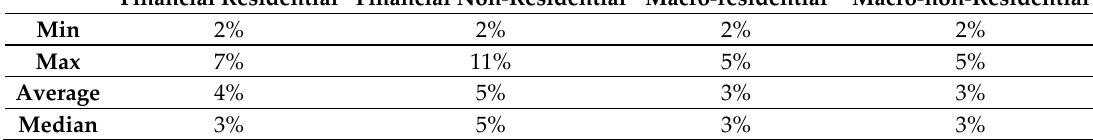
Figure 4. Discount rate used by Member States and associated statistics.